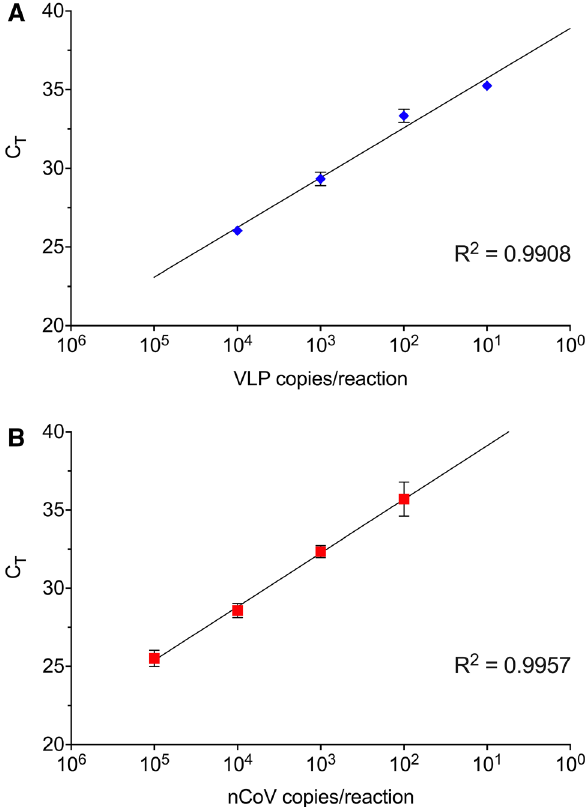
Figure 4. Efficiency of TRIzol RNA extraction from serial-diluted SARS-CoV-2 spiked sample s. SYBR one-step RT-qPCR analysis targeting SARS-CoV-2 N gene was performed on DMEM spiked with tenfold serial dilutions of ( A ) SARS-CoV-2 virus-like-particles (VLPs; blue diamond), and ( B ) heat inactivated 2019 novel coronavirus (nCoV; red square). Total RNA was extracted from each concentration using Eppendorf epMotion. Results are shown as mean ± SE of three technical